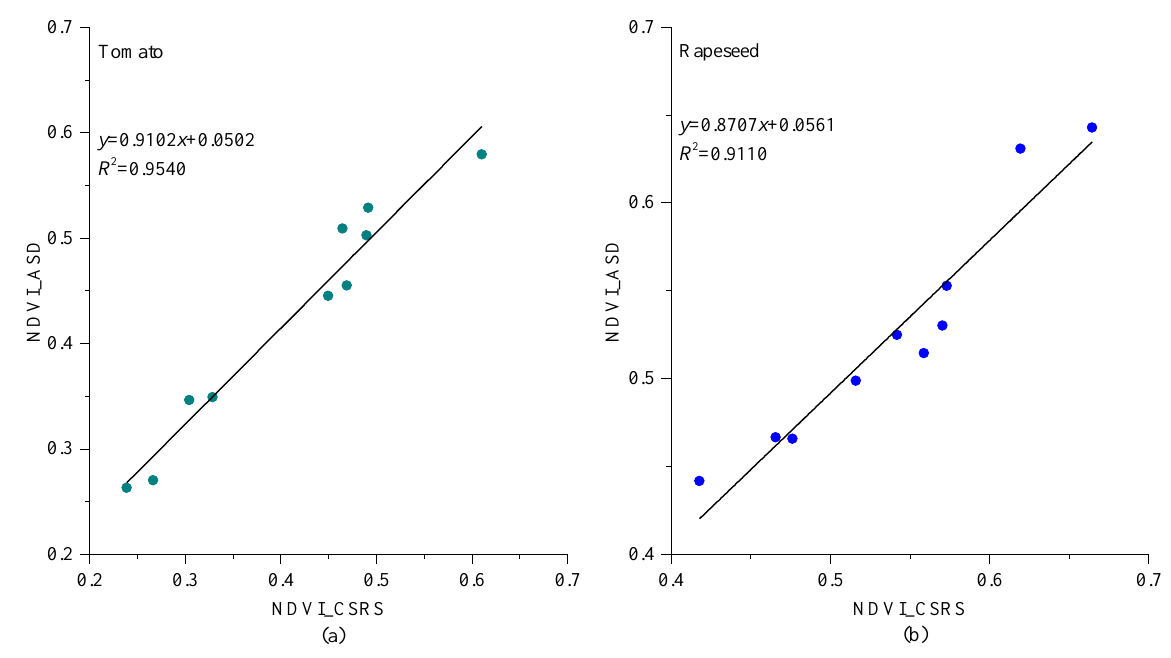
Figure 17. Fitting curve of the NDVI measured by the CSRS and ASD spectrometer. ( a ) Tomato; ( b ) Rapeseed.